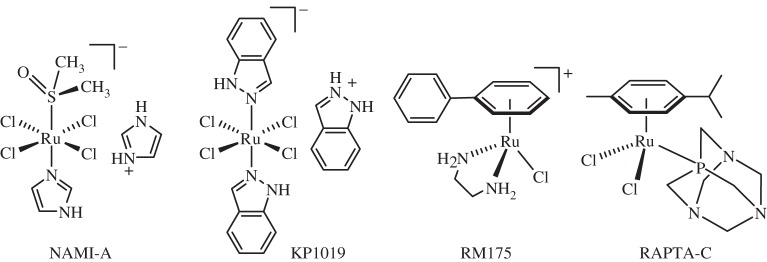
Some RuIII and RuII anti-cancer complexes. Both NAMI-A and KP1019 (as the sodium salt NKP-1339 and IT-139) are in clinical trials.